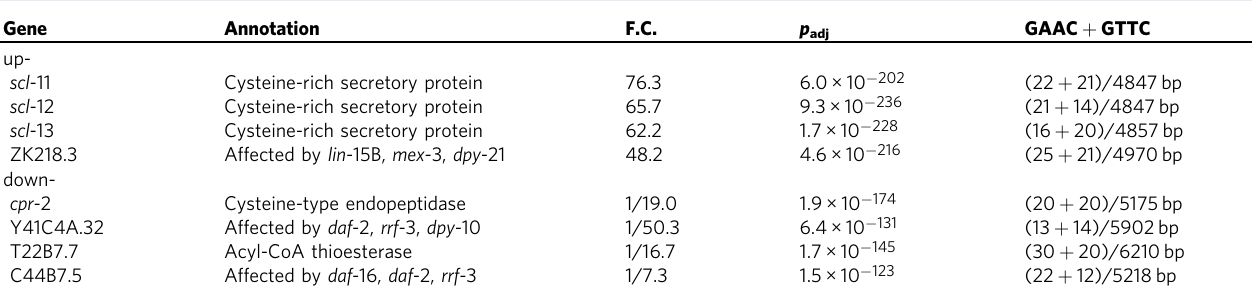
Table 1 The top-ranked up- and down-regulated genes in D4 samples of Caenorhabditis. elegans , which were fed PT-containing bacterial food.